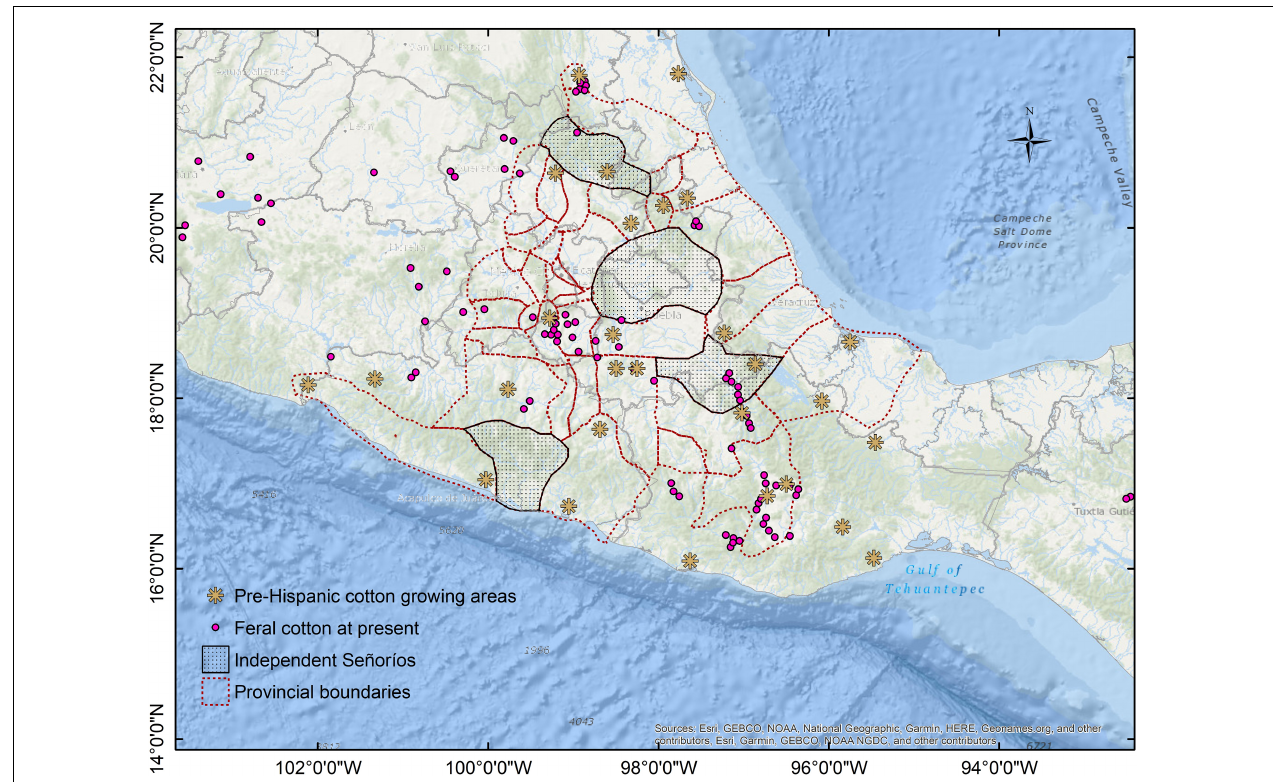
FIGURE 9 | Feral cotton occurrences and pre-Columbian cotton-growing areas within the Aztec Empire and nearby provinces. Modified from Berdan